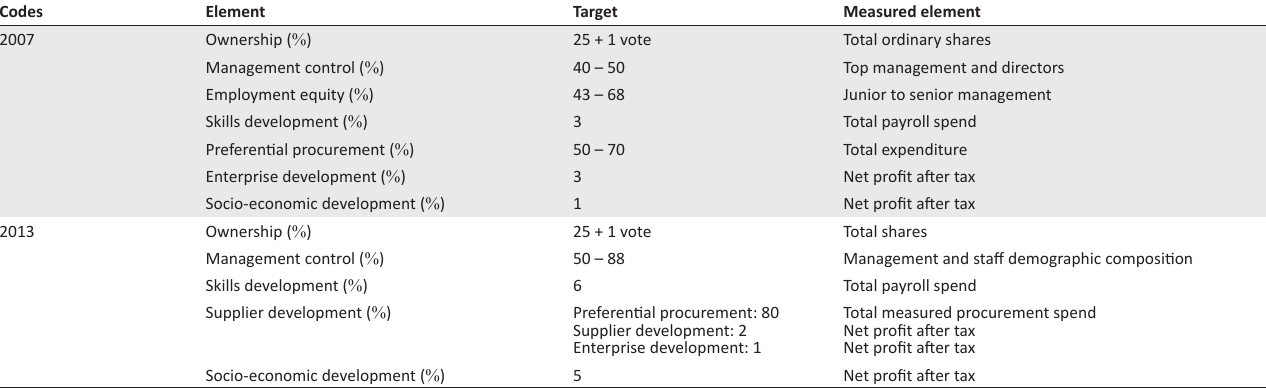
TABLE 1: Compliance targets for Broad-Based Black Economic Empowerment scores under the 2007 and 2013 Codes.